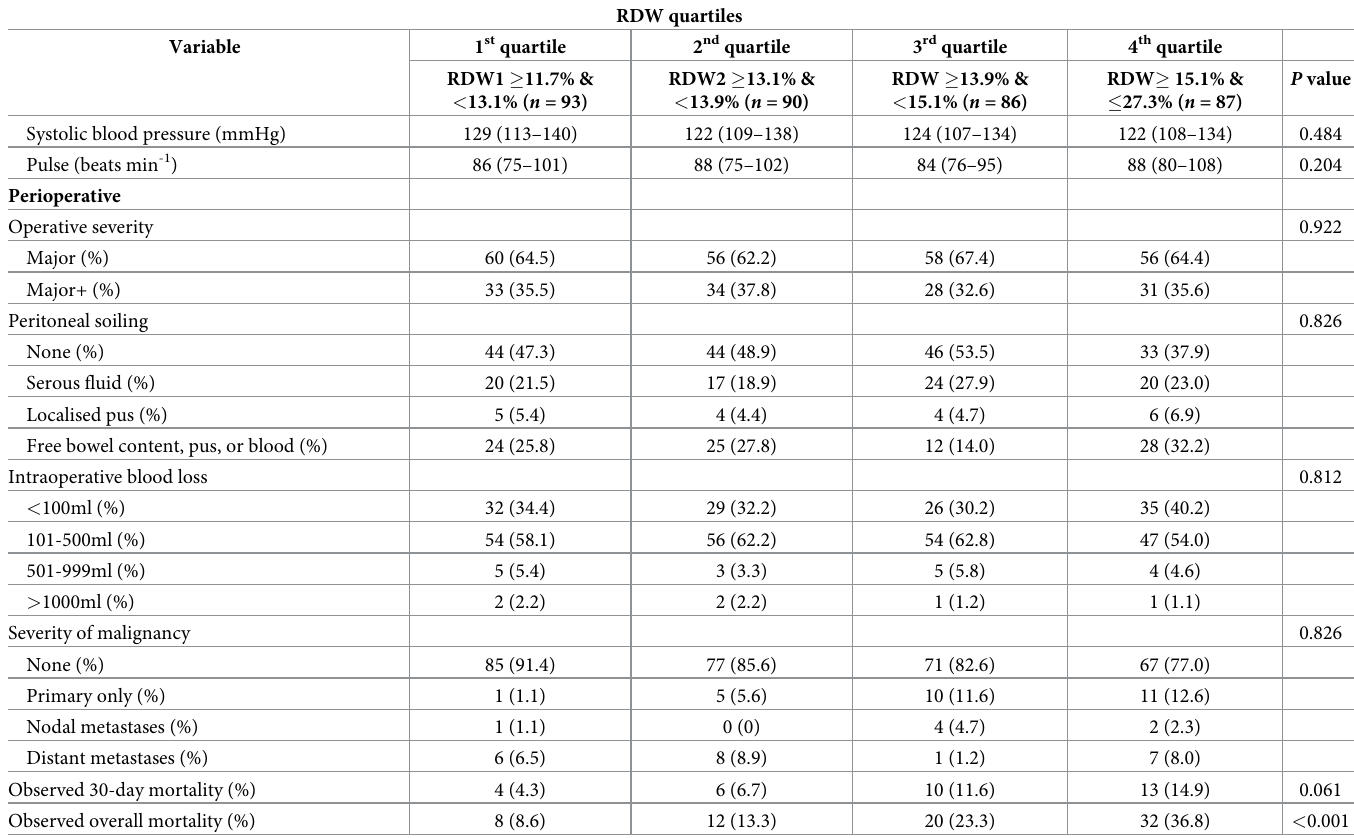
the table. P values were calculated using the Kruskal-Wallis test for continuous variables and χ 2 test/Fisher’s exact test was used for categorical data (testing for overall difference in RDW quartiles). Obstruction (= small & large bowel obstruction), sepsis (= peritonitis, abdominal abscess, perforation, anastomotic leak), ischaemia